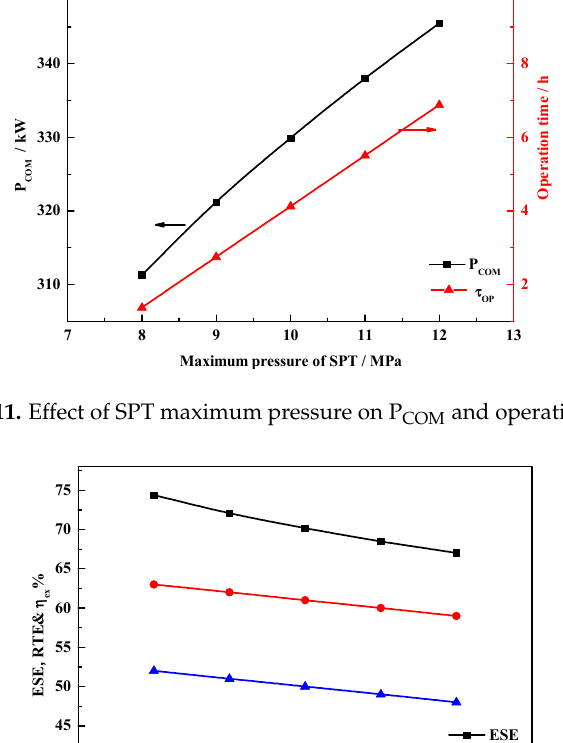
Figure 12. Effect of SPT maximum pressure on ESE, RTE, and η ex .